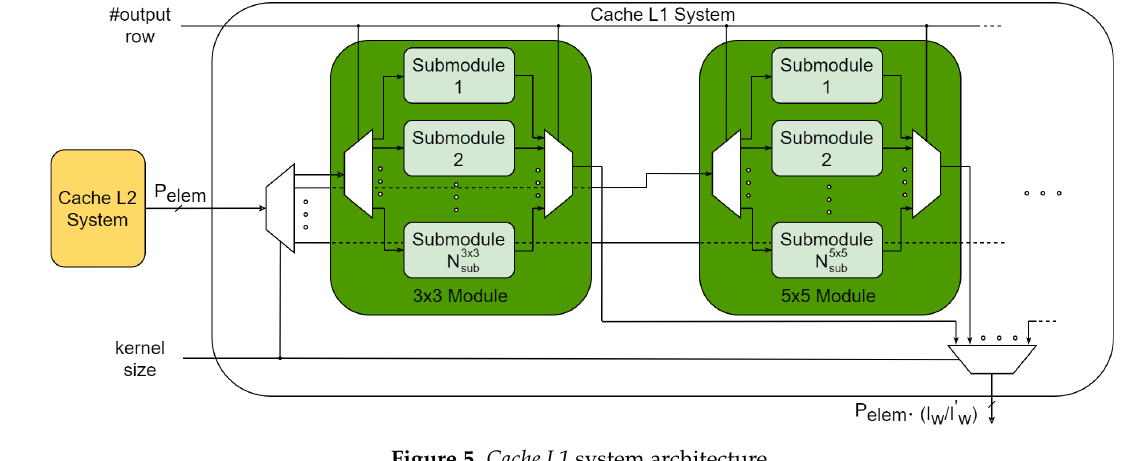
Figure 5. Cache L1 system